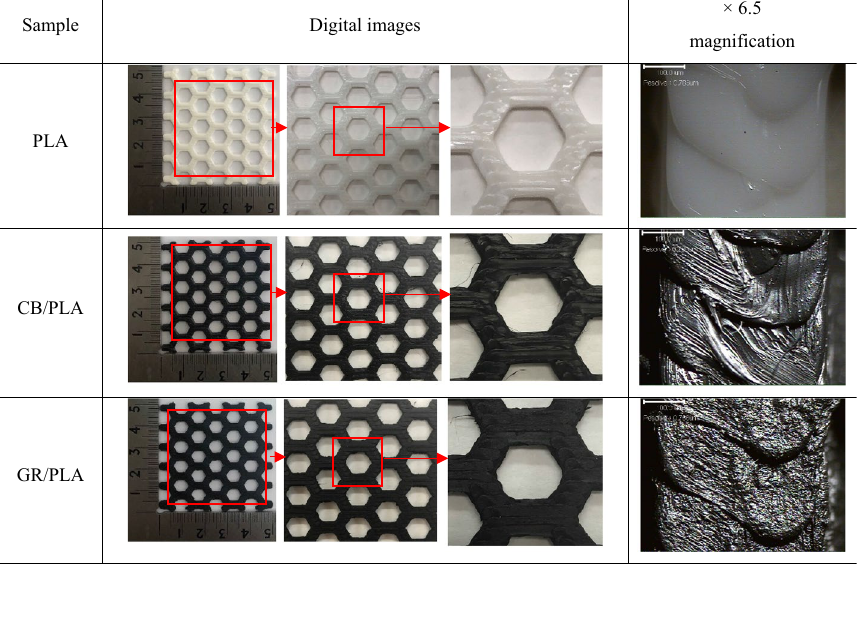
Table 4 Morphology of 3D printed honeycomb samples Sample